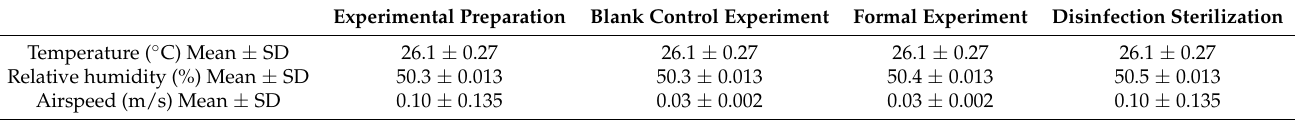
Table 1. Environmental parameters in the sampling